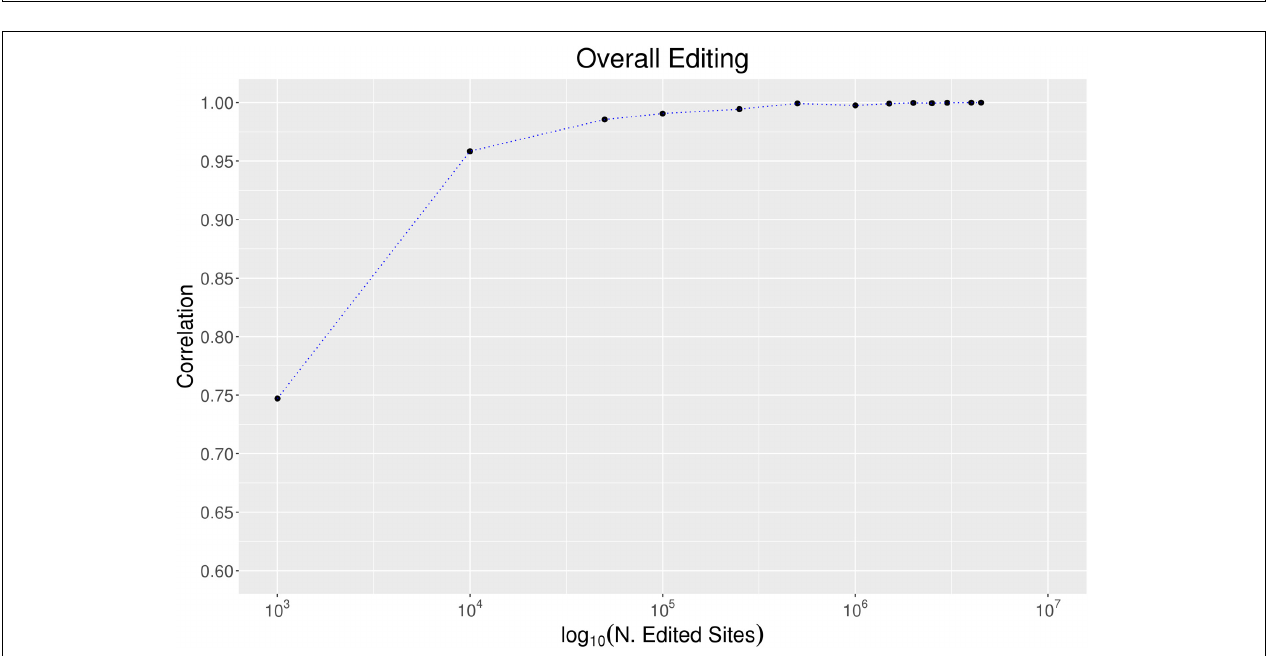
FIGURE 5 | Overall editing levels in 10 selected “body sites” from the GTEx project. Each box plot represents samples from one tissue type. The overall editing level is defined as the percentage of edited nucleotides at all known editing sites. Cerebellum and skeletal muscle emerge, respectively, as the most edited tissue and the less-edited tissue among the analyzed tissues.